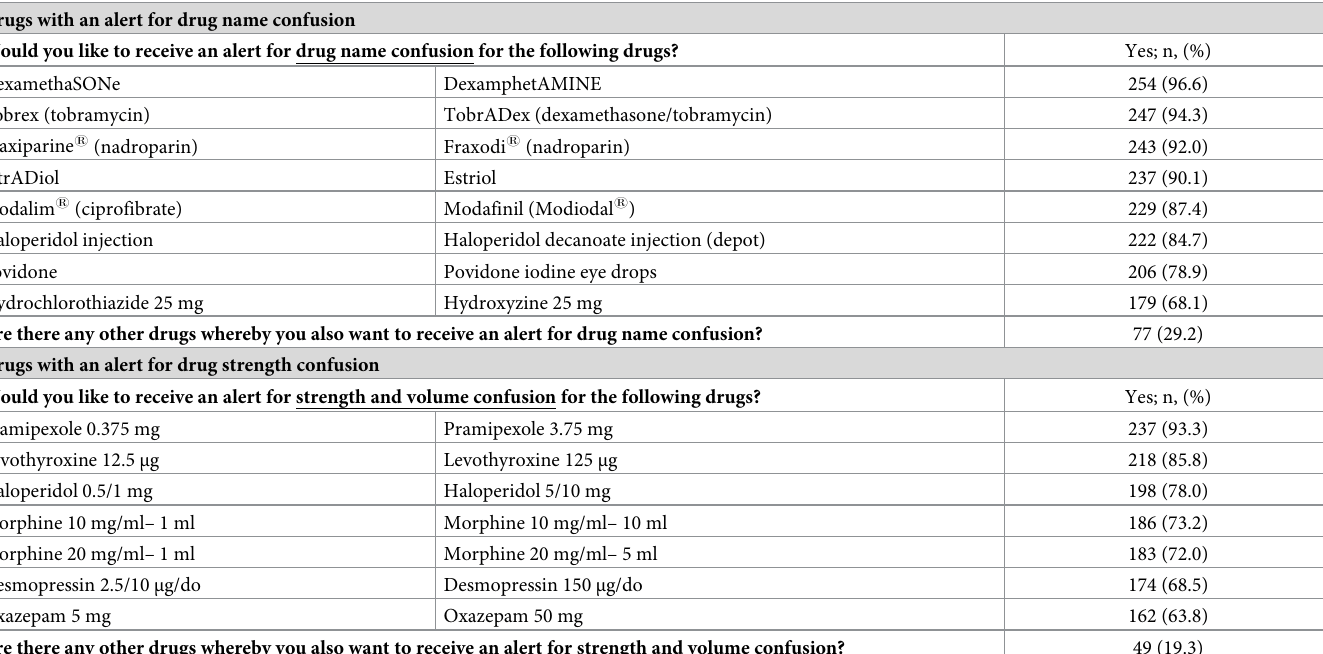
Table 3. Overview of the alerts for name and strength confusion and the proportion of respondents that is satisfied with the alert. Drugs with an alert for drug name confusion Would you like to receive an alert for drug name confusion for the following